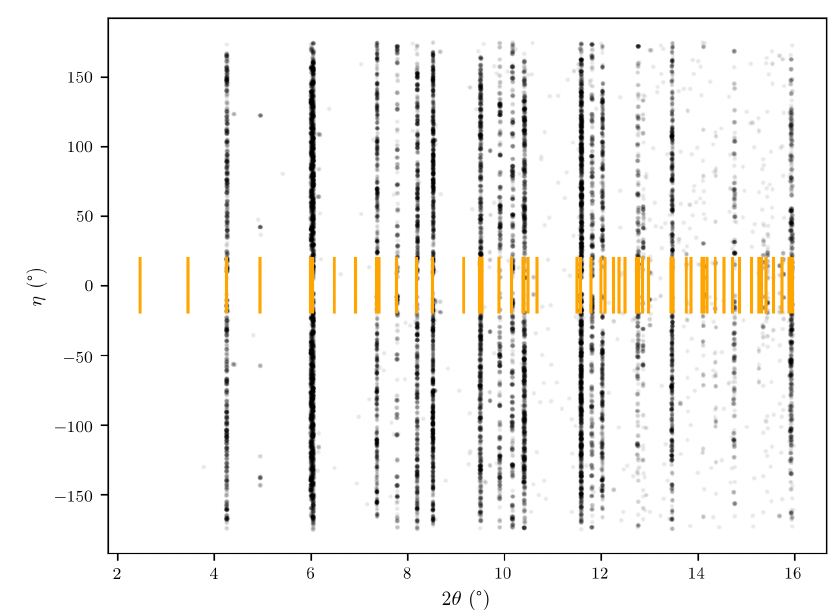
Figure 11. Indexation of peaks not belonging to tin grains for one horizontal slice through the heat treated sample. The position of each diffraction peak is given by the 2 θ and η angles (cf. Figure 2). The orange lines indicate the theoretical 2 θ angle of diffraction peaks originating from a powder of hexagonal Cu Sn . 6 5